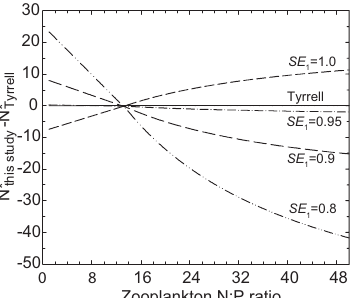
Fig. 9. Estimated deep ocean N* plotted against the N:P ratio in herbivores ( R Z org ), using different fraction of herbivore excretion occuring in the surface layer (SE 1 = 0 . 80, 0.90, 0.95 or 1.0). Pa- rameters other than R Z org and SE 1 are kept similar with base run (Table 1). The N* value was corrected from N* in Tyrrell’s original model without